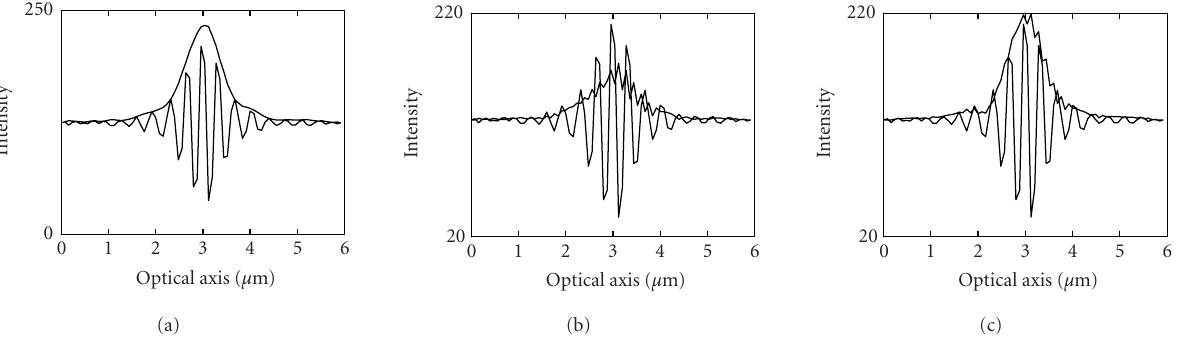
Figure 3: Rough profile: (a) ( k , m ) = (0,1); (b) ( k , m ) = (2,2); and (c) ( k , m ) = (2,3).